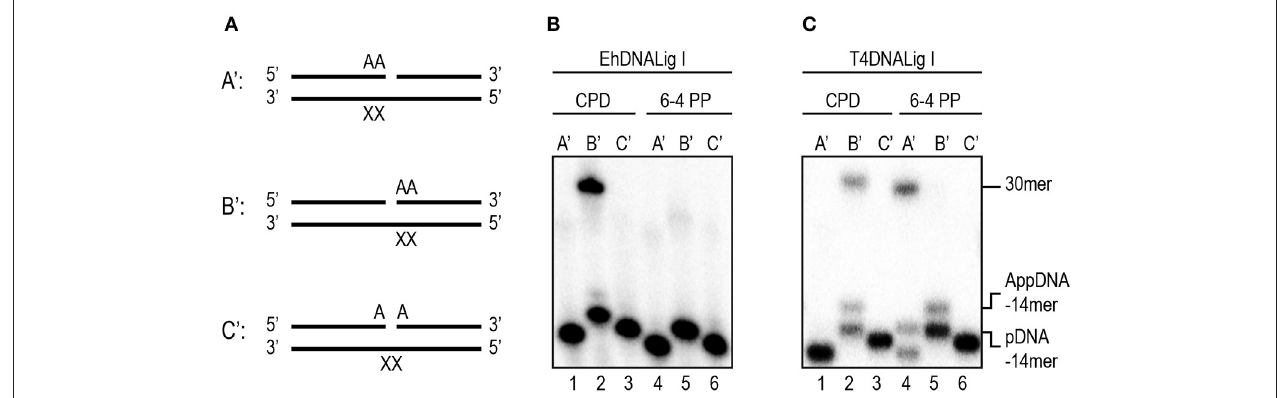
FIGURE 3 | EhDNALigI nick-sealing activity of substrates with UV radiation damage. (A) Schematic representation of the substrates used to evaluate DNA ligation of UV-damaged DNA templates. The thymine dimers (CPD or 6-4PP) are represented as “XX.” In the three cases, the damage is located at the template strand, while the complementary strand contains two adenines at 3 ′ -OH end in A’, 5 ′ -PO 4 in B’ or the nick (one at the 3 ′ -OH and one at the 5 ′ -PO 4 ) as in C’. (B) Nick-sealing reactions with EhDNALigI, with substrates containing CPD (lanes 1–3) or 6-4PP (lanes 4–6). (C) As in (B) , but using T4 DNA ligase. pDNA indicates the phosphorylated substrate DNA, while AppDNA indicates adenylated substrate by a DNA ligase. The substrate and the ligation product are labeled with